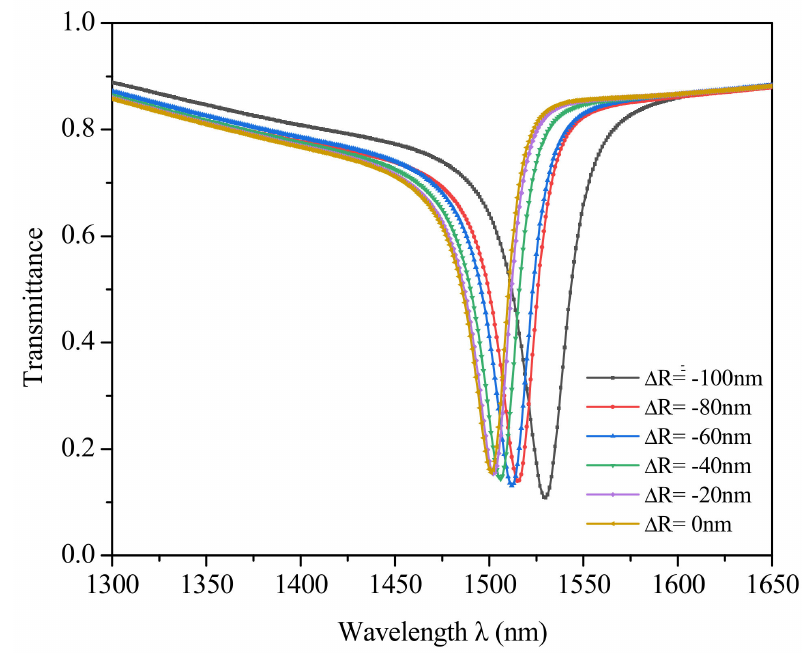
Figure 4. Transmission spectra of different ∆ R